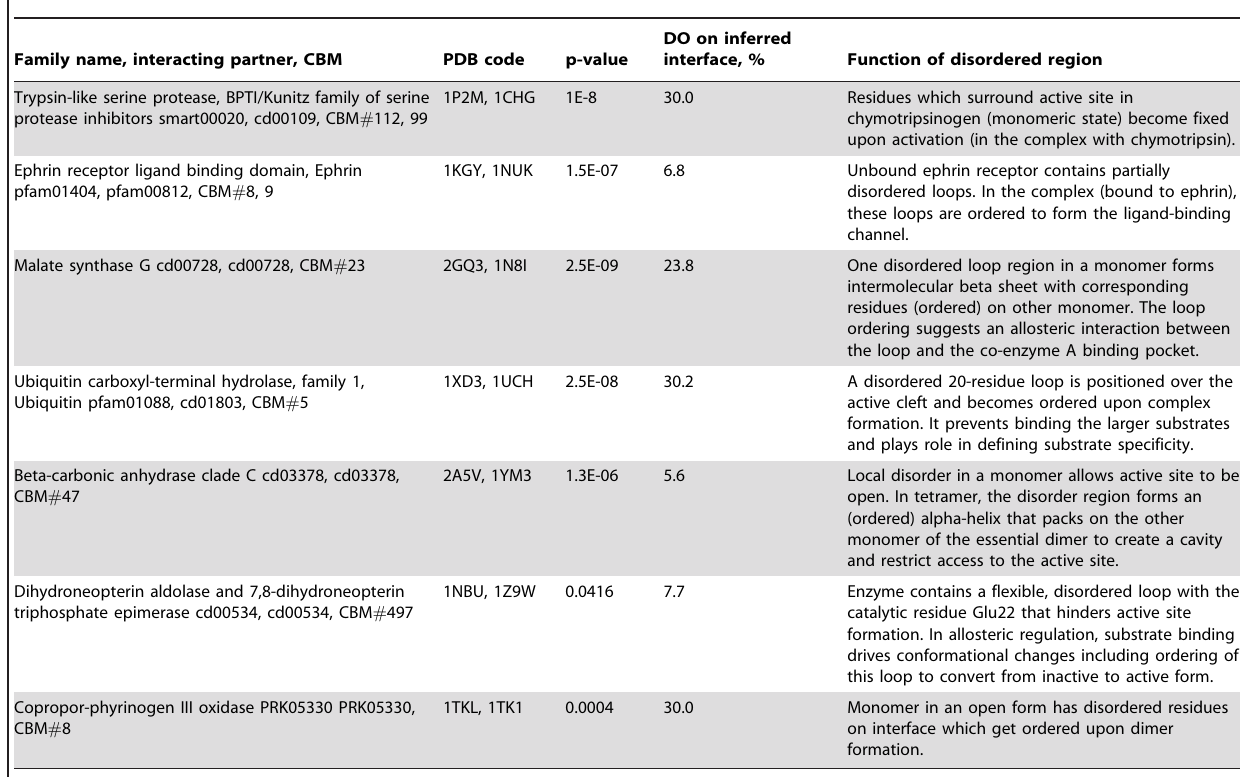
Table 2. Examples of protein families with the disorder-to-order transitions on or near interfaces.